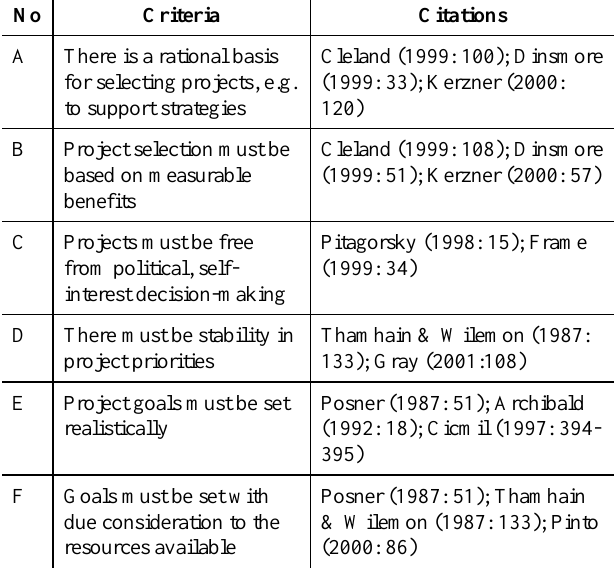
Table 13: A rational decision-making